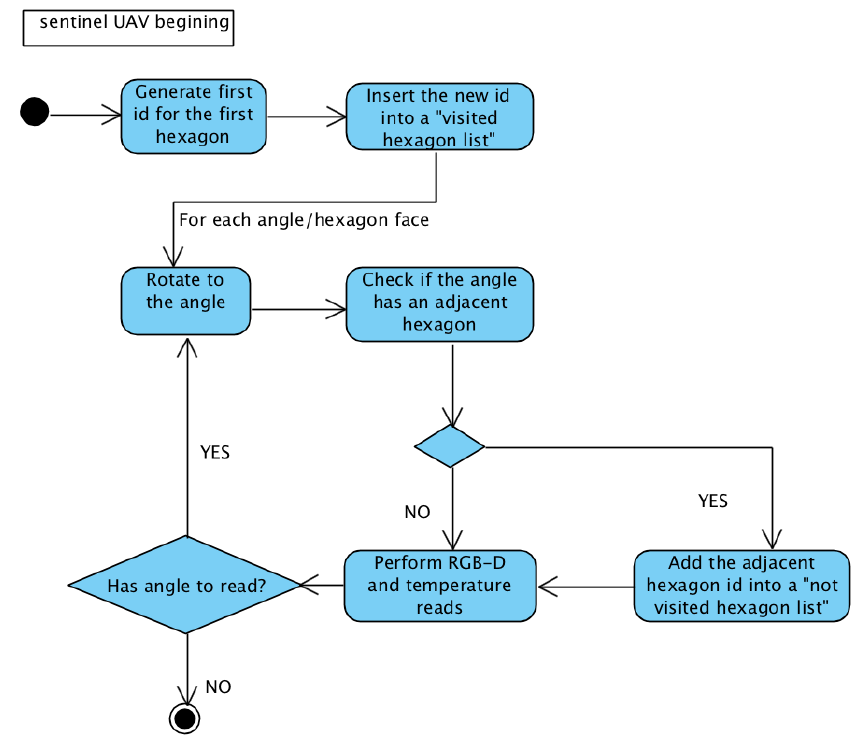
Figure 4. First sentinel UAV exploration.